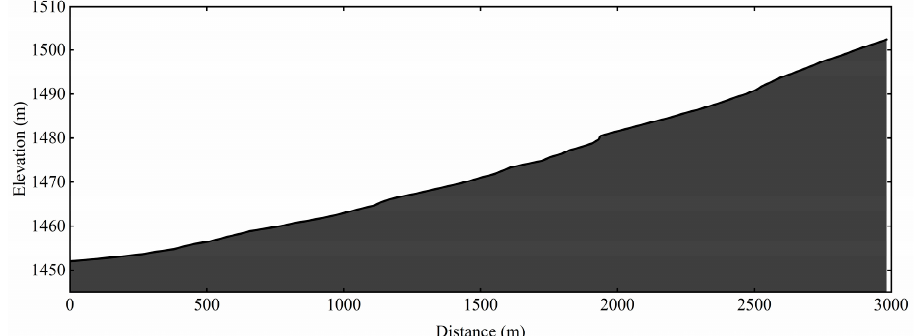
Figure 2. Course and elevation profile of the 3 km uphill skating field test.